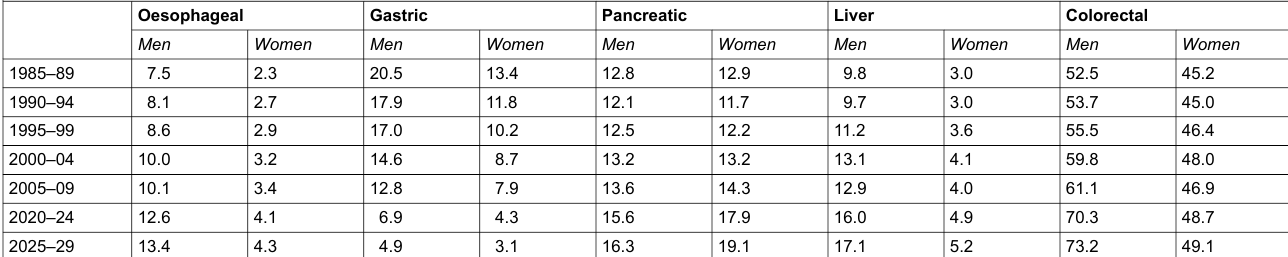
Table 2: Incidence rates by gender from 1985 to 2009 and Joinpoint predicted incidence rates stratified by gender for 2020–24 and 2025–29 (median per year per 100 000 inhabitants) in Switzerland for all five tumour entities (crude rates). Oesophageal Gastric